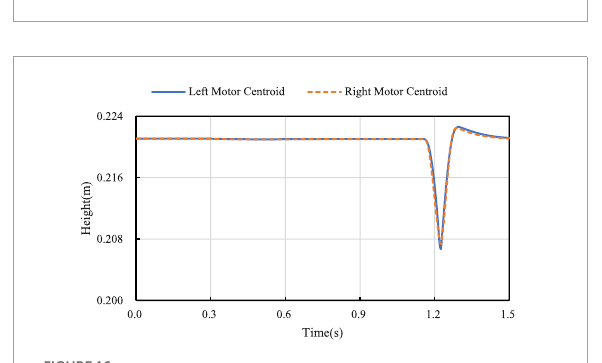
FIGURE17 Obstacle crossing of wheel-leg without adaptive